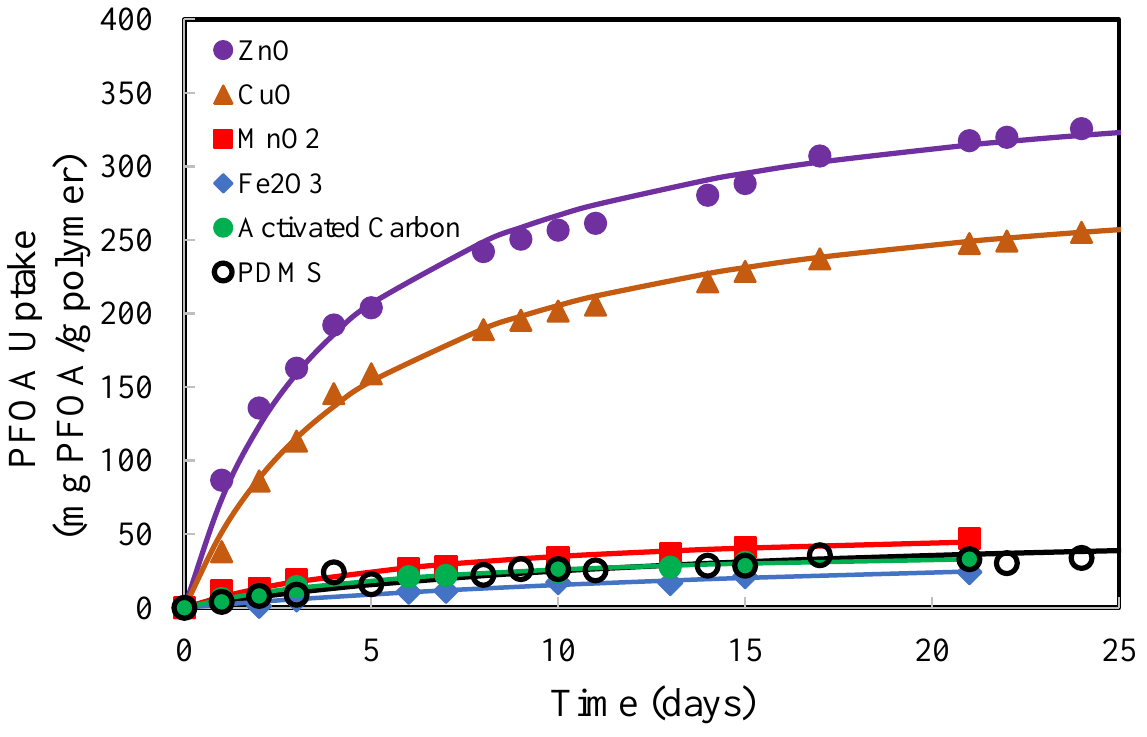
Figure 4. PFOA uptake in PDMS with 10 wt% imbedded particles. Initial PFOA solution was 1000 mg/L in deionized water. The initial mass of each membrane sample was 0.1 g.